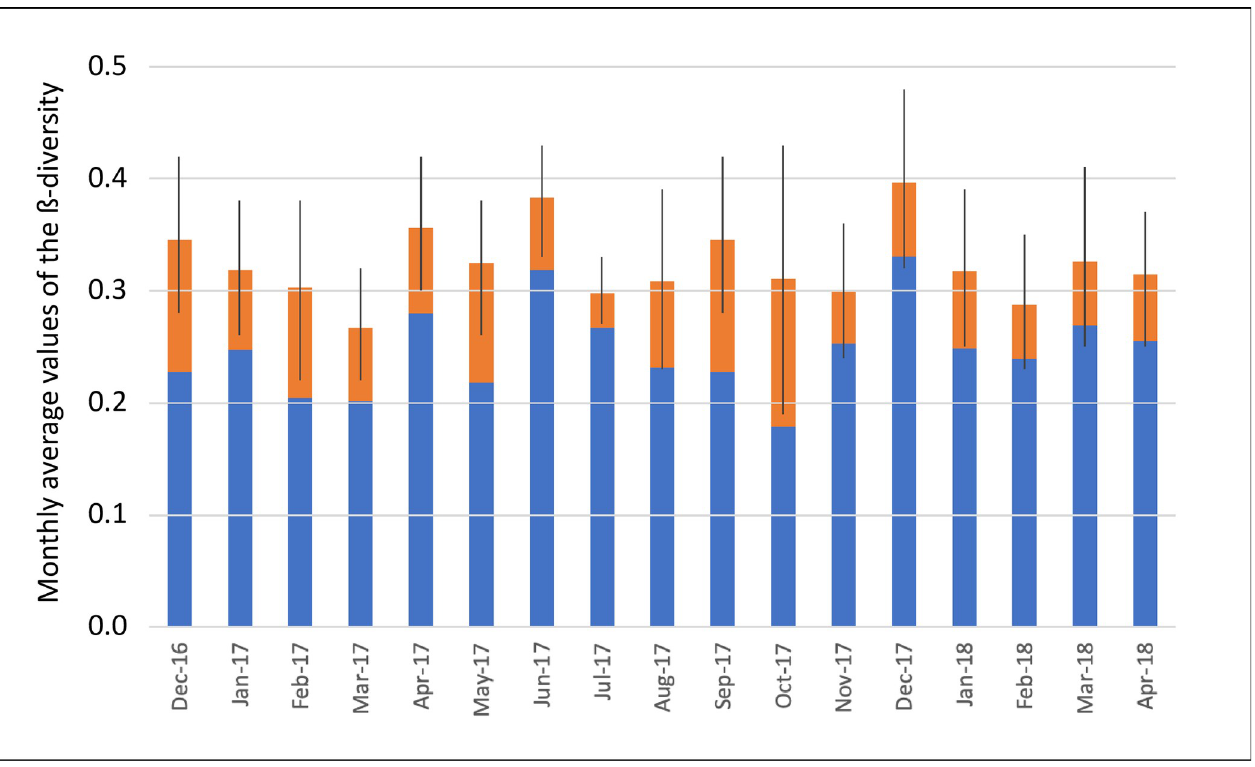
Fig 4. Variations in the average monthly ß-diversity values at the six sampling stations during the 17-month monitoring period. The blue bar indicates the turnover component of the ß-diversity; the orange bar represents the nestedness component of the ß-diversity; and the black line indicates the standard deviation around the monthly average value of the total